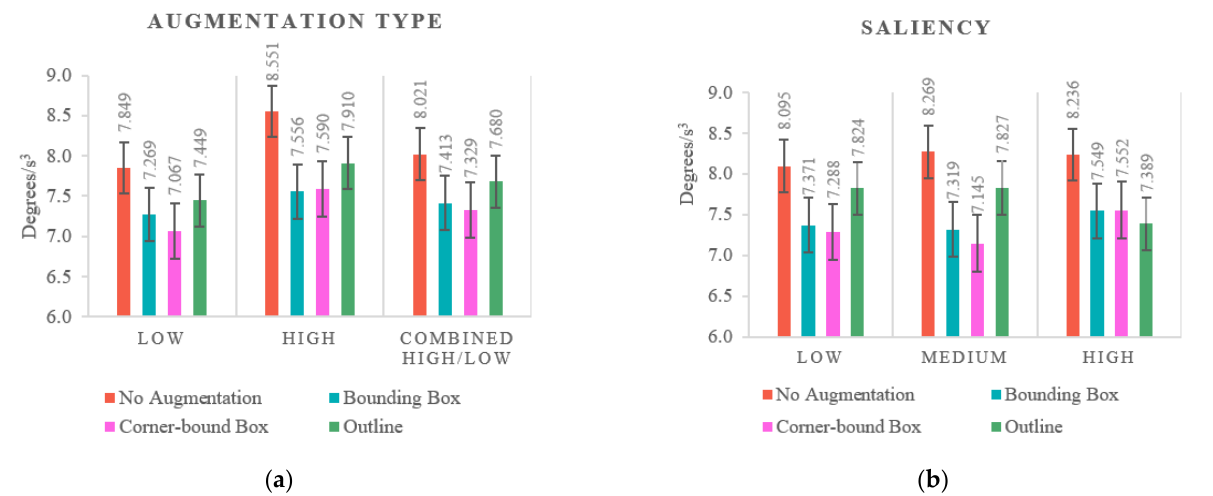
Figure 3. Graph of jerk with augmentation type and saliency. Levels of jerk magnitude are shown on both graphs with the left graph ( a ) showing jerk levels for each augmentation type and the right graph ( b ) showing jerk levels in the different saliency conditions. Simulated computer vision accuracy groups (low, high, and combined) are show on of the left graph ( a ) and levels of augmentation saliency (low, medium, and high) are shown in the panels of the graph on the right ( b ). Error bars reflect the standard error of the mean.